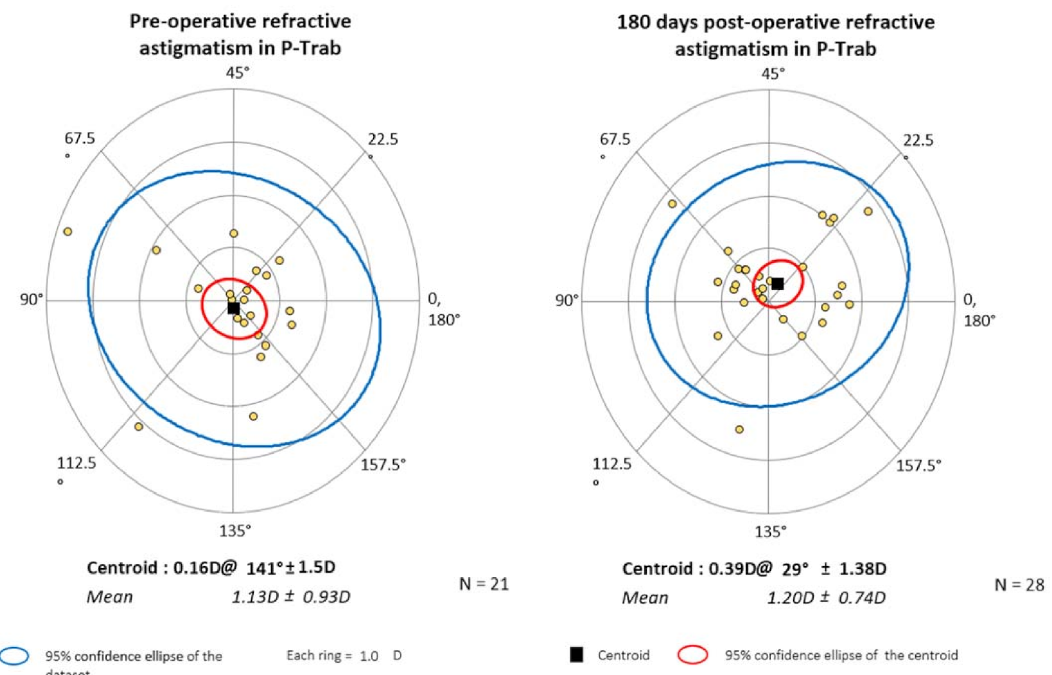
Figure 3. The mean values of astigmatism, with the axes, presented in centroid form on double angle plots for the P-Trab group (The black square indicates the centroid. The red circle indicates the 95% confidence ellipse of the centroid. The blue circle indicates the 95% confidence ellipse of the dataset. Yellow dots indicate individual values of astigmatism. Each ring indicates 1.0 D. Astigmatism trend in P-trab is oblique before and after the surgery).